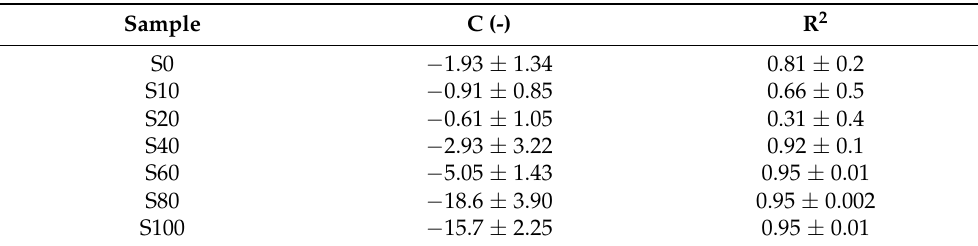
Figure 10. Parameter C values for samples S0–S100. Table 6. The parameters of the model describing the logarithmic dependence of the complex viscosity ( η ∗ ) on the angular frequency ( ω )